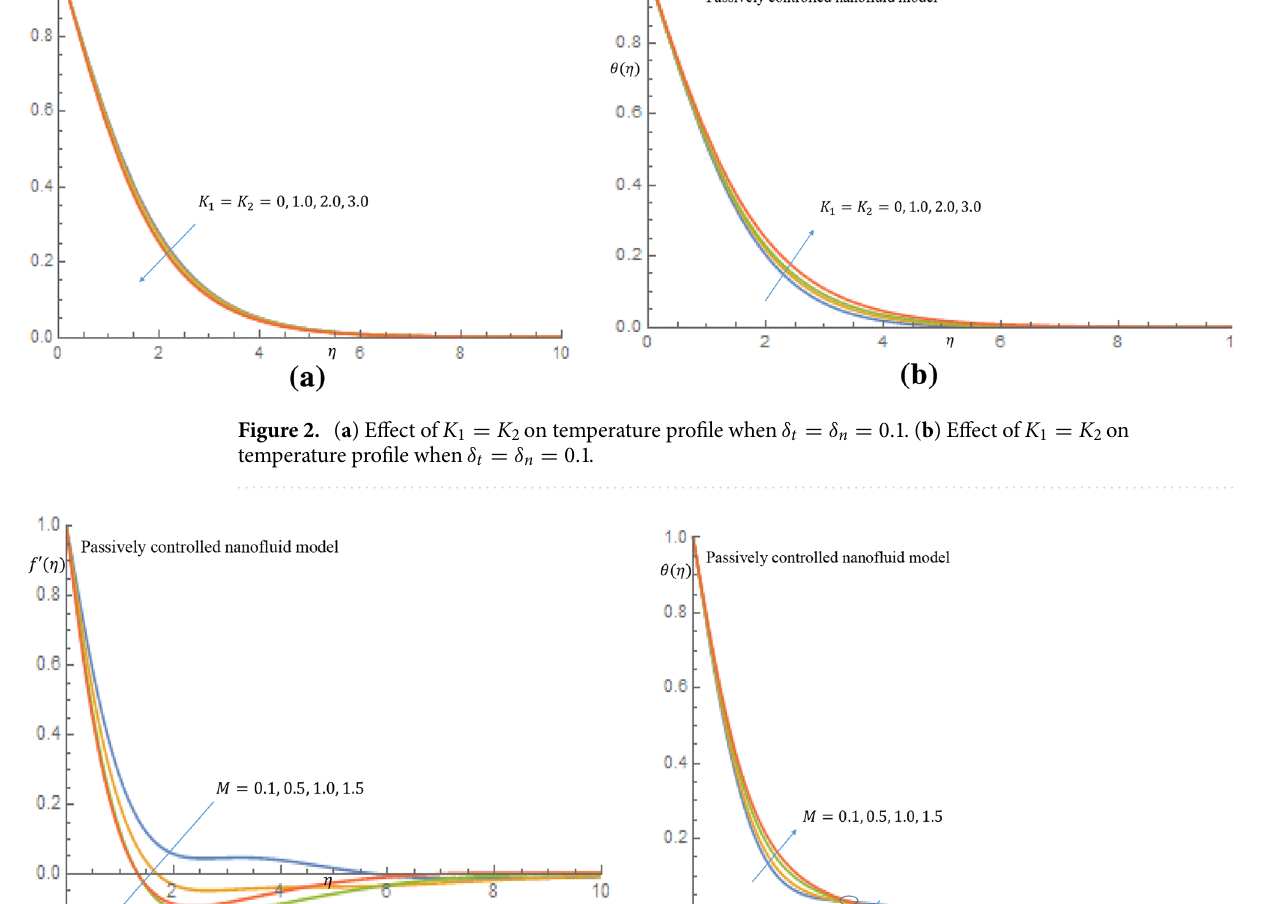
Fig. 6b for case of passive control of nanoparticles that as G r is increased all profiles merged at a distance very